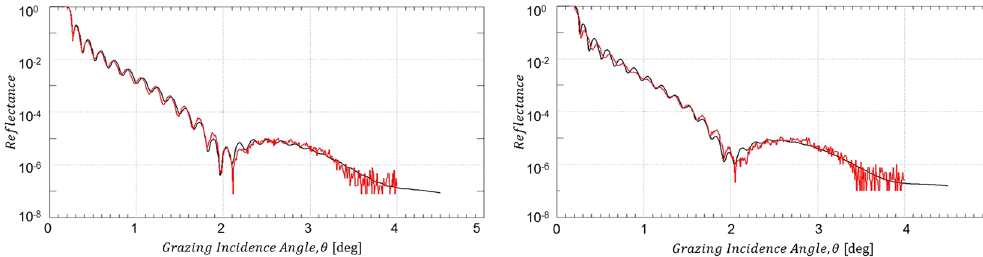
Figure 2. XRR data from B 4 C-coated test mirror right after O 2 /Ar plasma cleaning. Left hand side: Non a-C coated part; right hand side: Formerly a-C coated part (red solid lines: experimental XRR data; black solid lines: IMD